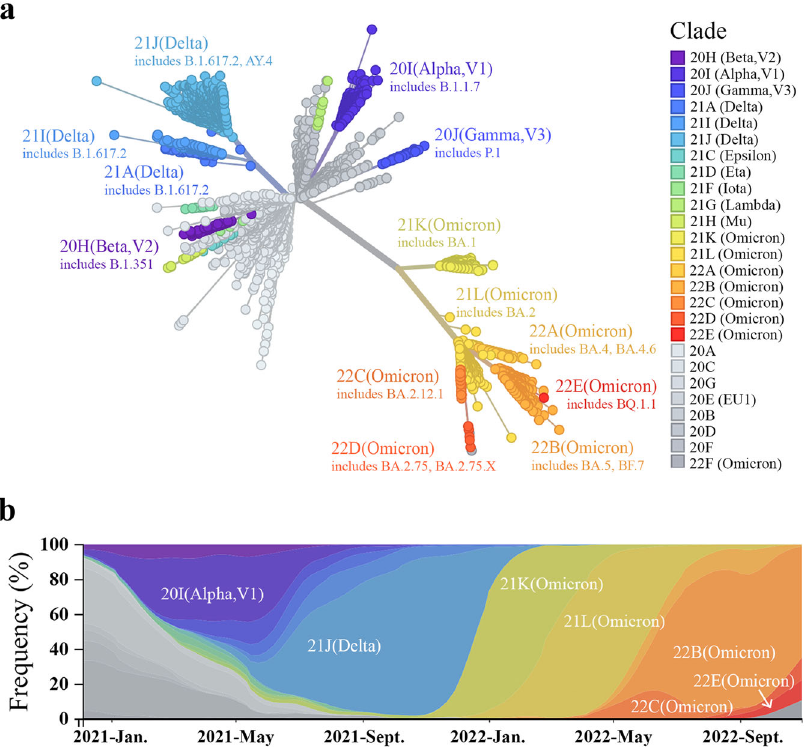
Fig. 1 Circulating strains of SARS-CoV-2 are fast-changing. a Genetic relationships of global SARS-CoV-2 strains. The unrooted phylogenic tree is constructed by Nextstrain according to the sequences of 3050 SARS-CoV-2 spike glycoproteins from GISAID collected between December 2019 and October 2022 (https://nextstrain.org/ncov/gisaid/global/6m?l = unrooted&m = div). The tree is colored by clade and branch length represents the divergence of each clade. The Omicron variants show the highest antigenic distinction to the ancestral strain. b Time course of prevalent SARS-CoV-2 variants substitutions worldwide. The x -axis represents the date and the y -axis shows the frequencies of viral strains in percentage. Omicron subvariants have rapidly outcompeted previously prevalent Delta variants and become